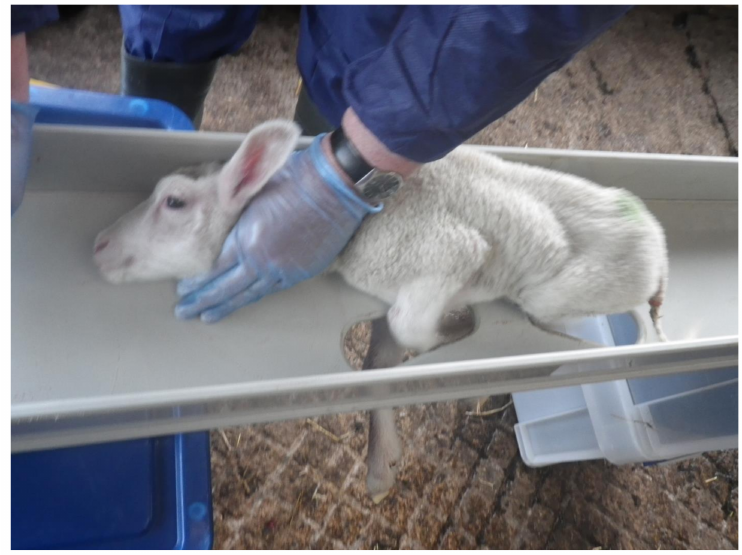
Figure 1. Lamb held in a restrainer prior to euthanasia with light